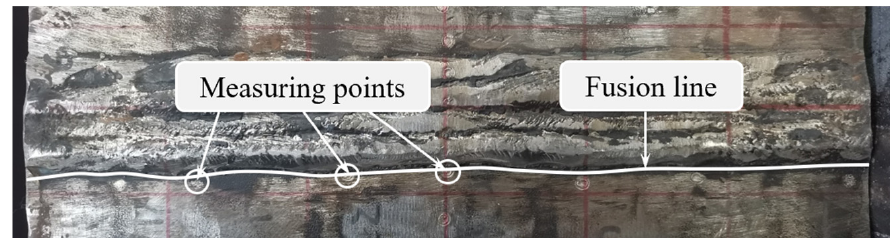
Figure 28. The stress on path L yA = 25 .